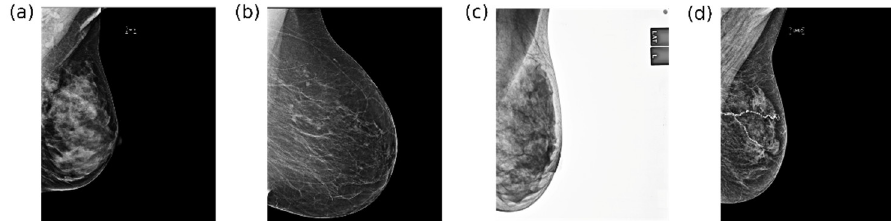
Figure 12. MG images from the INCISIVE retrospective database in original size, all intended for presentation, and originating from different data providers: ( a ) AUTH, ( b ) GOC, ( c ) HCS, and ( d ) UNS. Note that images from different providers and different manufacturers might undergo different processing steps from a raw image format, which is an unavailable piece of information.